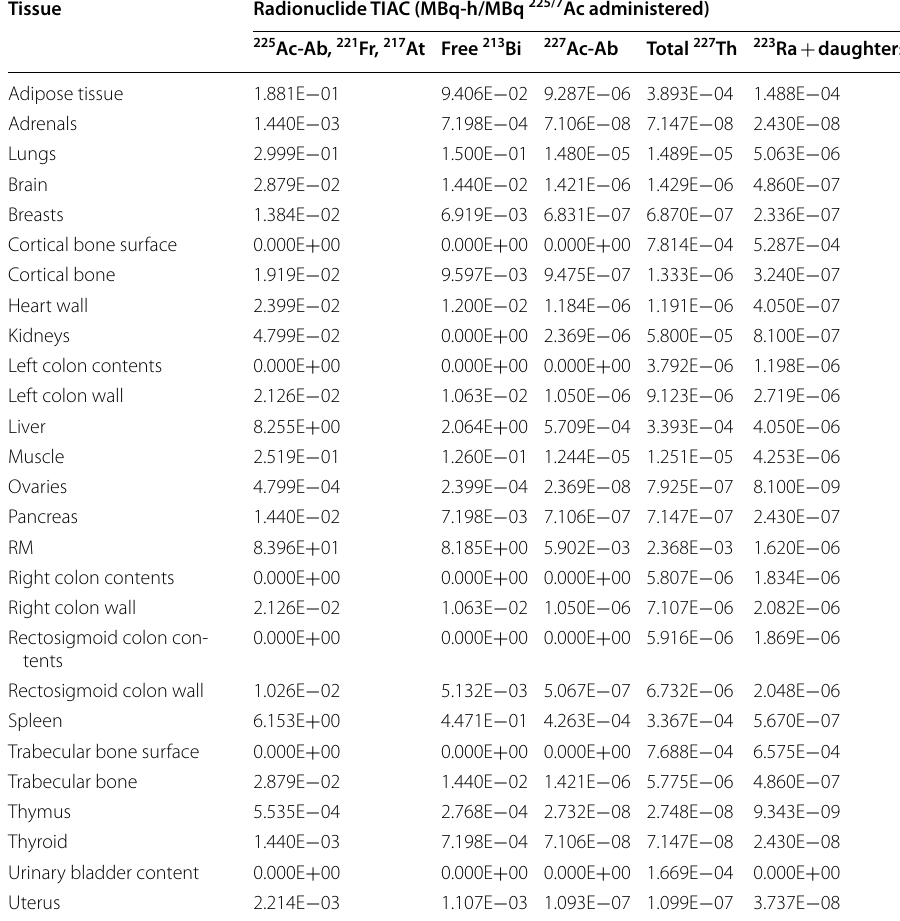
Table 3 Summary of model-derived TIAC for each radionuclide